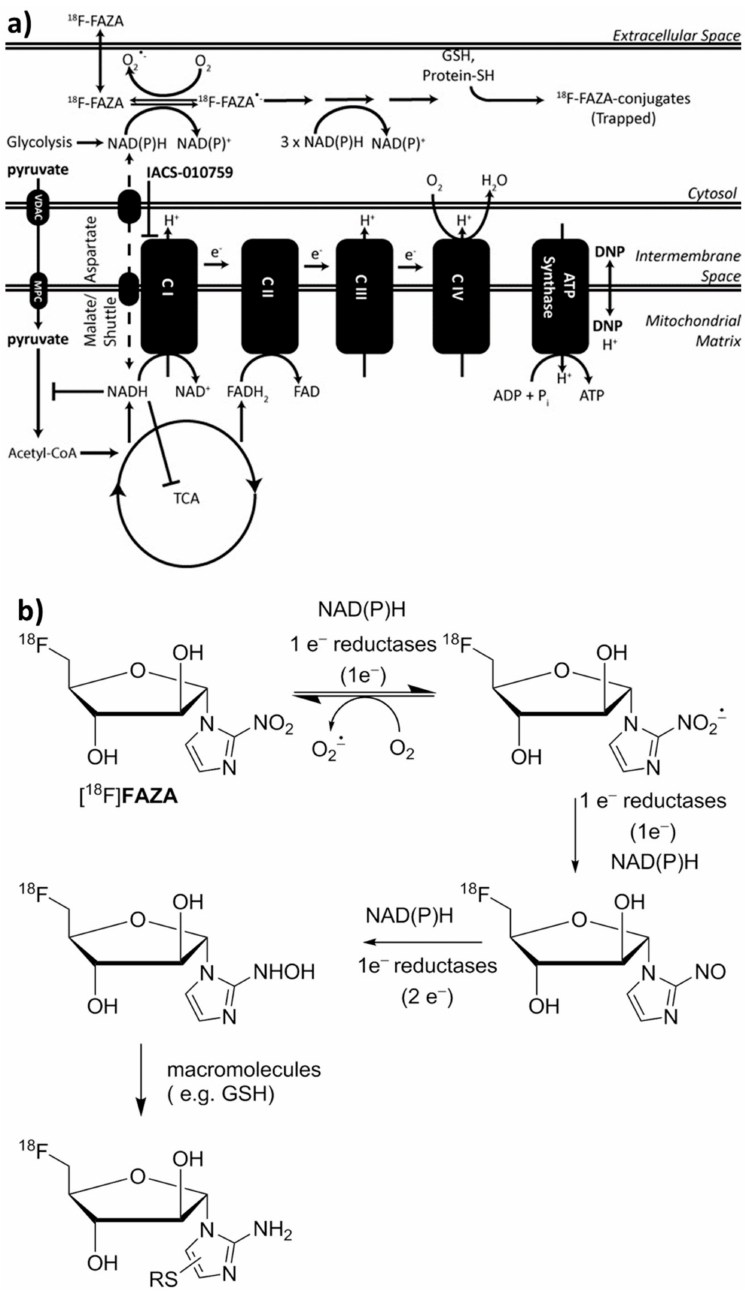
Figure 1. [ 18 F]FAZA yields a mechanism-based PD readout of complex-I inhibitor IACS-010759. ( a ) Proposed mechanism of [ 18 F]FAZA retention in relation to ETC inhibition. ( b ) The first step in